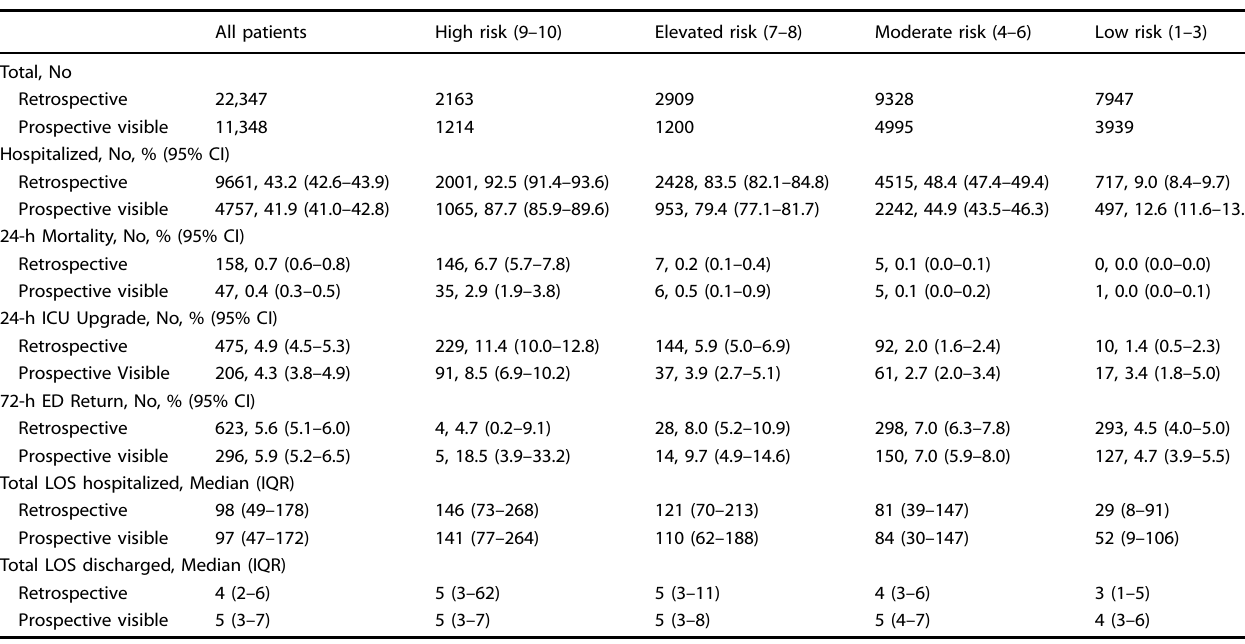
Fig. 4 Distribution of ED visits across risk levels (bottom panel) and percent of patients within each risk level who met outcome criteria (top panel) during the index hospital visit are shown for the ( a ) inpatient care and ( b ) critical care outcome models. Data for the decision group only are shown in solid colors (blue and red) and data for all patients are shown in gray. Table 2. Patient-oriented outcome